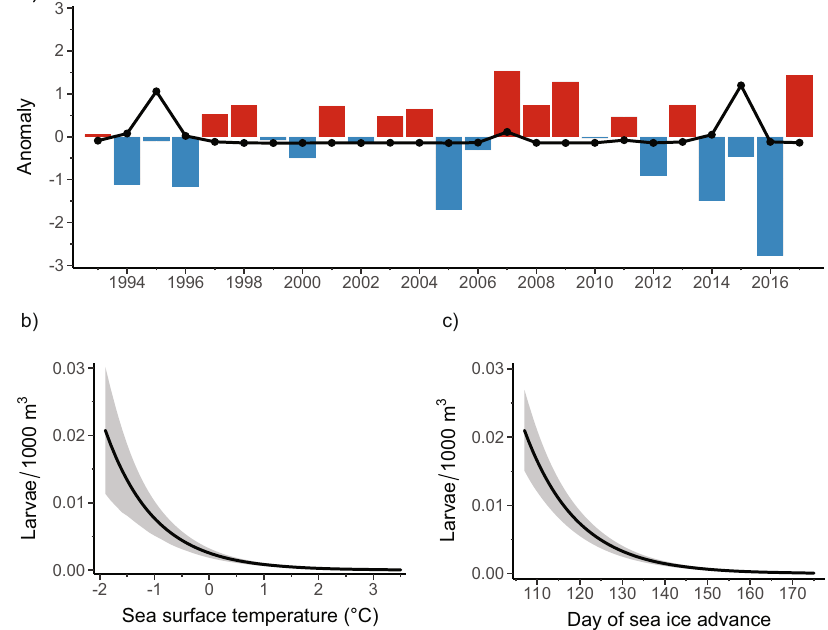
Fig. 2 Relationships between sea surface temperature, sea ice, and Antarctic Silver fi sh abundance. a Positive (red; warmer temperatures) and negative (blue; cooler temperatures) anomalies in the standardized mean sea surface temperature (see “ Methods ” ) for the Palmer LTER study region (Supplementary Fig. 1) during austral summer (December, January, February). Standardized anomalies in mean annual larval Antarctic Silver fi sh abundance (larvae/1000 m 3 ) that were captured during January and February are overlaid (black dotted line). b , c Predicted impact (solid black lines) on larval Antarctic Silver fi sh abundance from b sea surface temperature ( p < 0.001) and c lagged day of sea ice advance ( p < 0.001) from the model (see “ Methods ” ). Sea ice advance was temporally lagged in the model to align with life history patterns in adult Antarctic Silver fi sh abundance. The shaded regions represent the 95% prediction interval, which considers uncertainty from the fi xed effects, zero-in fl ation, and random effects components of the fi nal model (Supplementary Fig. 2a 112 , see “ Methods ”